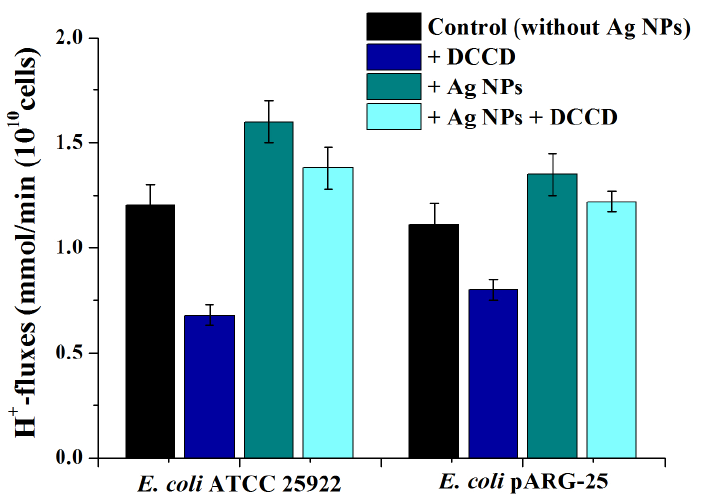
Figure 7. The effect of biogenic Ag NPs on H + -fluxes through the E. coli ATCC 25922 and E. coli